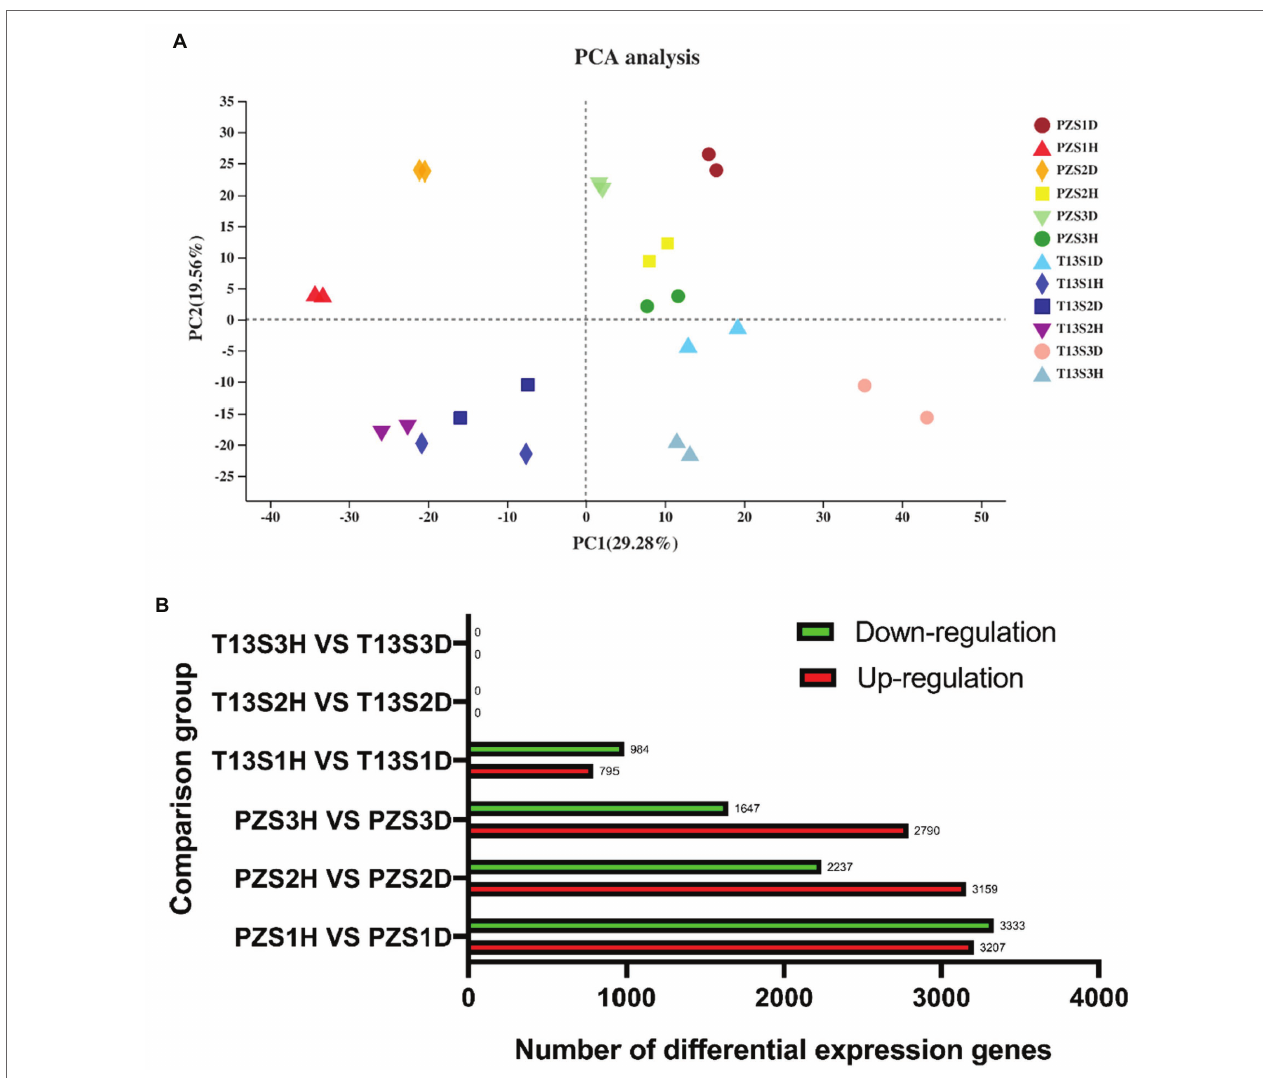
FIGURE 2 | Principal component analysis (PCA) and count of differentially expressed genes (DEGS) analysis. (A) PCA of all samples in the 12 groups with two biological replicates. (B) Sum of up- and downregulated DEG counts at least twofold in six pairwise comparisons (T13S1H vs. T13S1D, T13S2H vs.